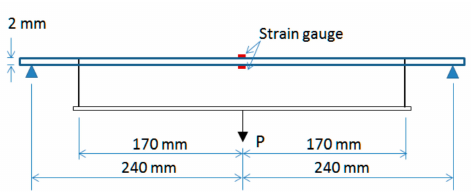
Figure 6. Schematic of the steel beam test.